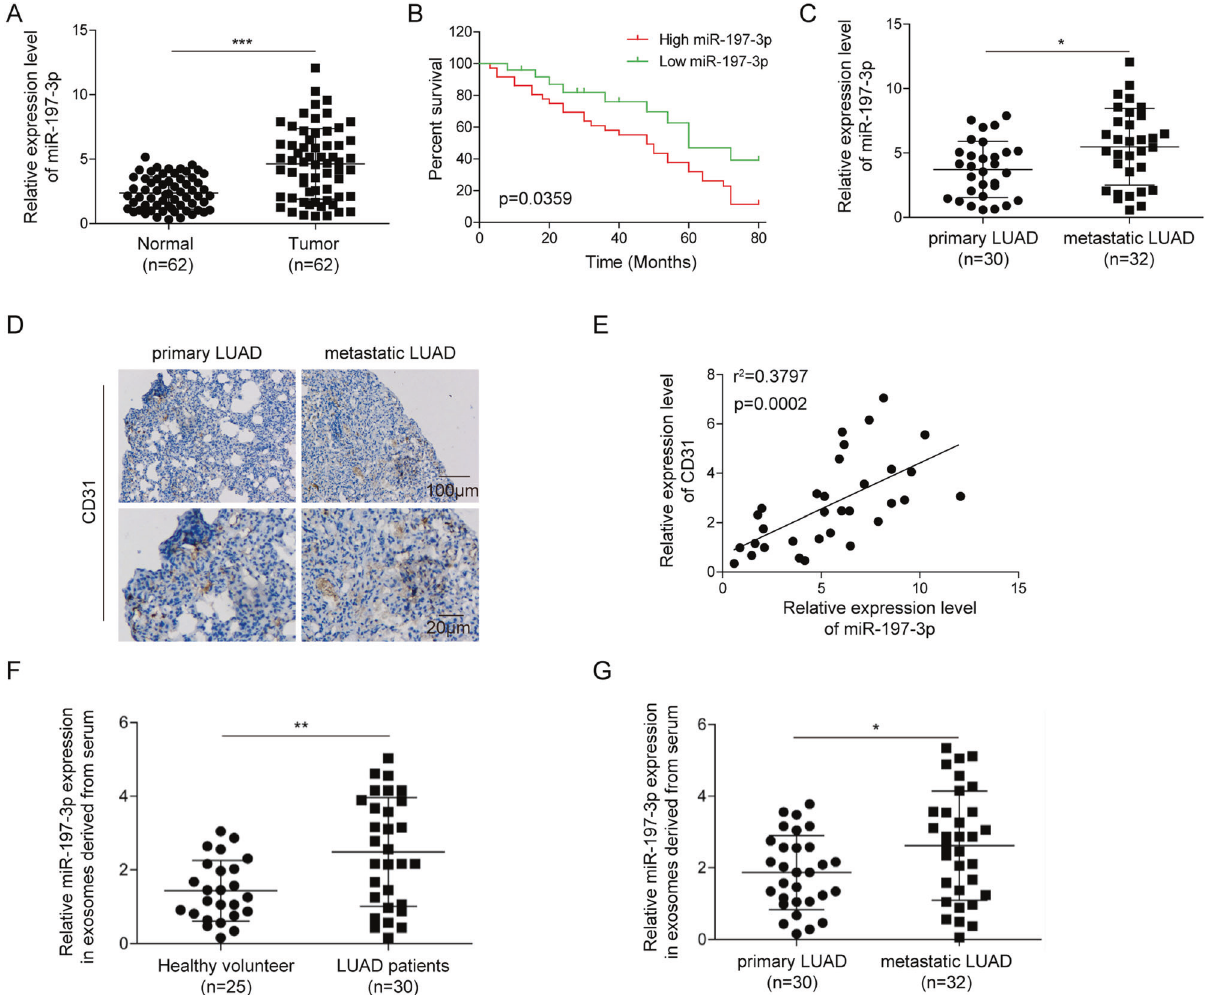
Fig. 1 Upregulation of miR-197-3p in LUAD tissues and exosomes positively correlates with metastasis and angiogenesis. A The miR-197- 3p level in normal and LUAD tissues was detected by qRT-PCR. B Kaplan – Meier survival analysis of LUAD patients. C The miR-197-3p level in primary and metastatic LUAD tissues was detected by qRT-PCR. D CD31 expression in primary and metastatic LUAD tissues was assessed by IHC. E Pearson correlation analysis between miR-197-3p and CD31 expression. F The exosomal miR-197-3p level from serum of healthy donor and LUAD patients was detected by qRT-PCR. G The exosomal miR-197-3p level from serum of primary and metastatic LUAD patients was detected by qRT-PCR. Data were representative images in D . * P < 0.05, ** P < 0.01, *** P < 0.001. 4 days. As shown in Fig. 4A – C, miR-197-3p mimics-Exo led to (Fig. 3C) assays unequivocally revealed that miR-197-3p mimics- signi fi cant induction of tumor volume and weight, whereas miR- Exo promoted capillary-like tube formation of HUVECs, while miR- 197-3p inhibitor-Exo suppressed tumor growth, compared with 197-3p inhibitor-Exo inhibited the formation of tube-like structure, corresponding controls. In addition, the vascular marker CD31 was suggesting that A594 or H1299 cells-derived exosomal miR-197-3p predominantly expressed in tumor xenografts of miR-197-3p was implicated in regulating angiogenesis. Additionally, wound mimics-Exo group (Fig. 4D). In contrast, the immunoreactivity of healing (Fig. 3D) and transwell migration (Fig. 3E) assays further CD31 was signi fi cantly repressed in tumor xenografts of miR-197- showed that miR-197-3p mimics-Exo or miR-197-3p inhibitor-Exo 3p inhibitor-Exo group (Fig. 4D). IHC analysis also showed that enhanced or impaired cell migration in HUVECs, respectively. miR-197-3p mimics-Exo remarkably decreased the expression of Collectively, these data indicate that LUAD cells-derived exosomal TIMP2/3 in the xenograft tumors, whereas miR-197-3p inhibitor- miR-197-3p promotes the proliferation, angiogenesis, and migra- Exo exerted an opposite effect on TIMP2/3 expression (Fig. 4E). In tion of HUVECs. It is worth noting that exosomes derived from addition, we further tested the effects of exosomes on the A549 or H1299 cells, including mimics NC-Exo and inhibitor NC- oncogenic properties of A549 and H1299 in vitro. As presented in Exo, transferred miR-197-3p to HUVECs, thus enhancing the Fig. S1A, B, CCK-8 and colony formation assays showed that no angiogenic and metastatic capabilities of HUVECs. signi fi cant difference in cell proliferation was observed in miR-197- 3p mimics-Exo or miR-197-3p inhibitor-Exo group, compared with Exosomal miR-197-3p promotes tumor growth and corresponding controls. Similarly, the metastatic capacities of angiogenesis in vivo A549 and H1299 cells did not change after the treatment of In order to validate the role of exosomal miR-197-3p in vivo, tumor different exosomes (Fig. S1C, D), indicating that exosomal miR- xenograft model was established. A549 cells-xenograft bearing 197-3p had no effect on the behavior of A549 and H1299 cells mice were subjected to designate treatment of exosomes every